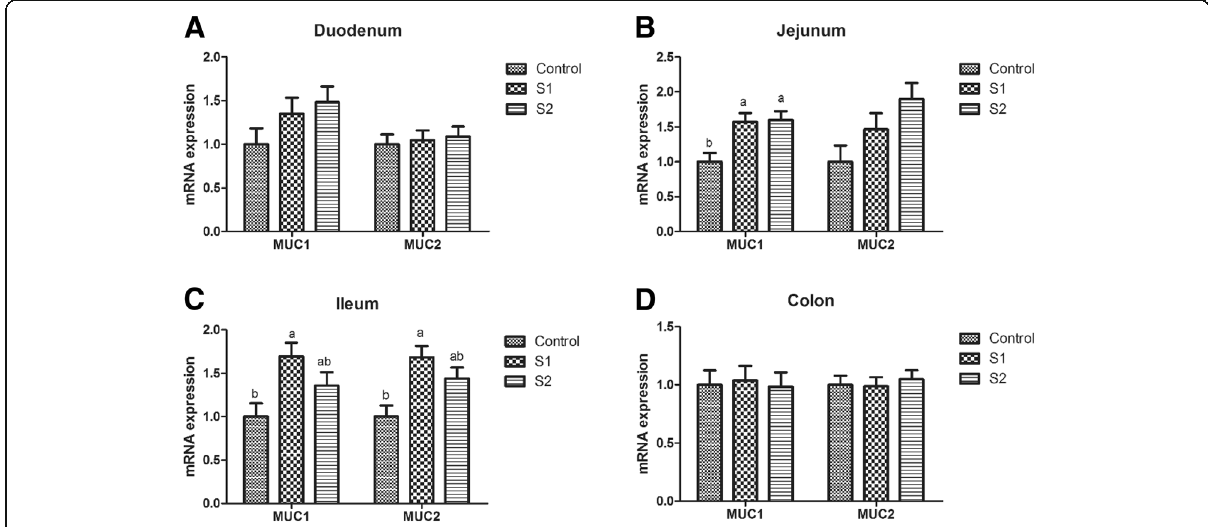
Fig. 5 Effect of gastric infusion of SCFA on the relative mRNA expressions of mucin in duodenum, jejunum, ileum, and colon of weaned piglets. S1, pigs treated with SCFA (acetic, propionic, and butyric acids; 20.04, 7.71, and 4.89 mM respectively); S2, pigs treated with SCFA (acetic, propionic, and butyric acids; 40.08, 15.41, and 9.78 mM respectively). a, b, means without a common superscript differ ( P <